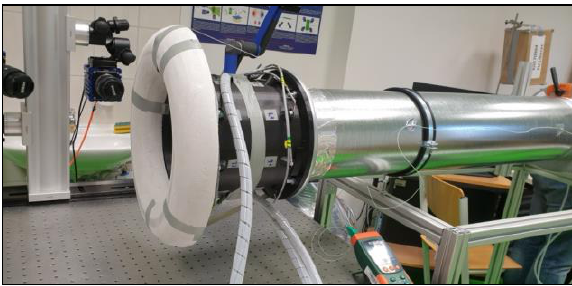
Fig. 7. The ultrasonic flowmeter prepared by 3D printing (together with an experimental line, see chapter 4 bellow).